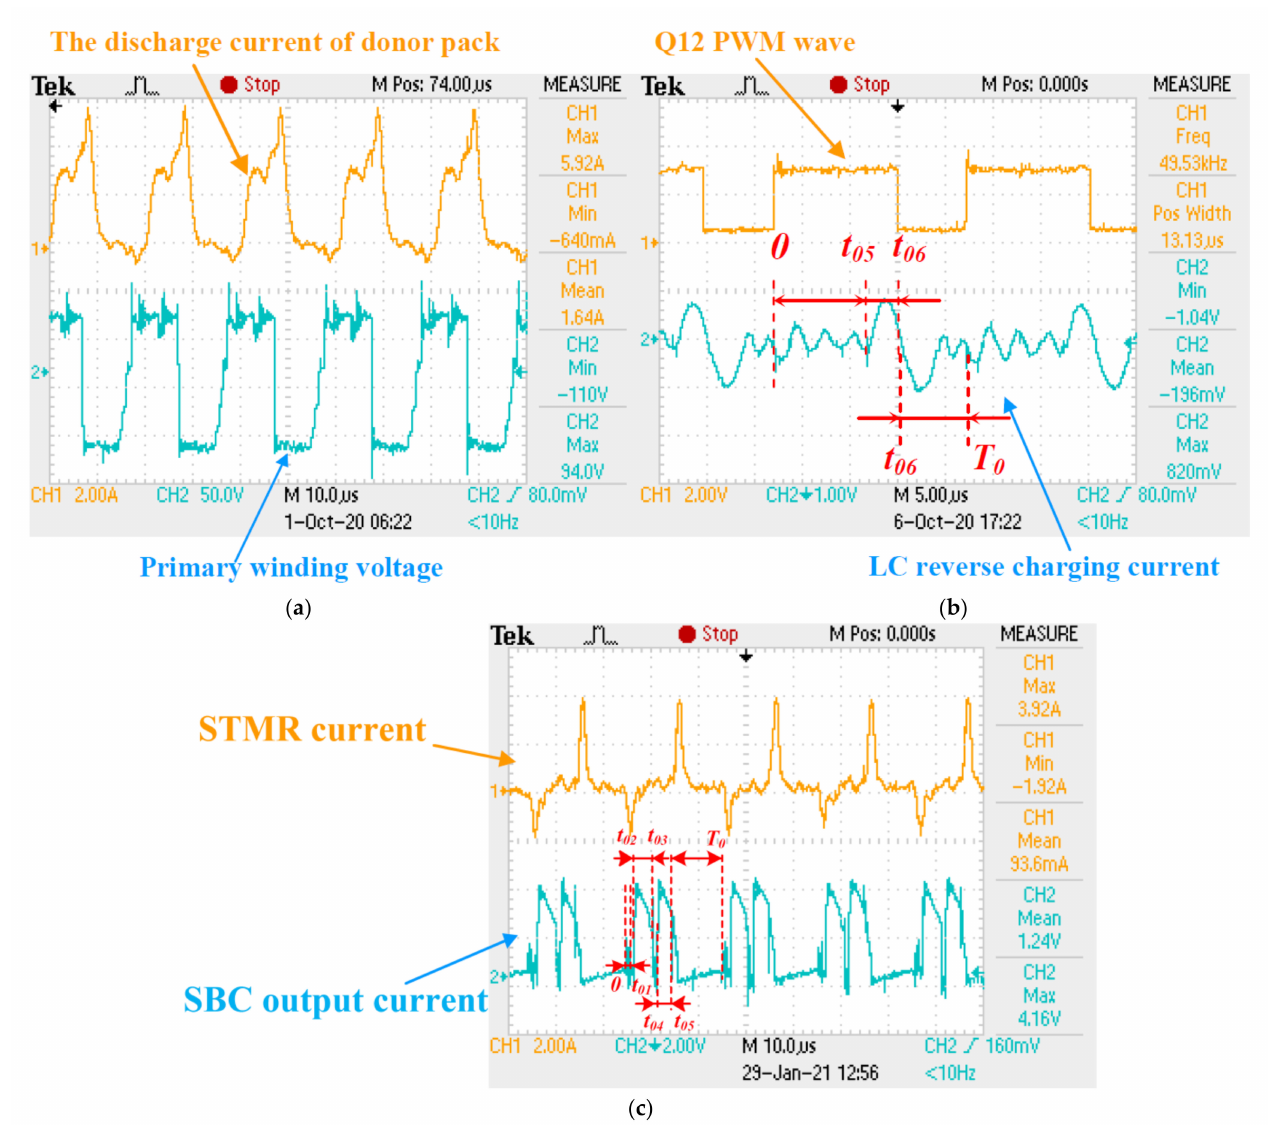
Figure 8. Experimental waveforms in 98 W, 50 kHz P2PG&AP mode when V BP 2 = 66.8 V, V BP 3 = 65.2 V, ∆ V BPi = 65.7 V. ( a ) Primary current and primary winding voltage. ( b ) Q12 PWM wave and LC reverse charging current. ( c ) SBC output current and STMR